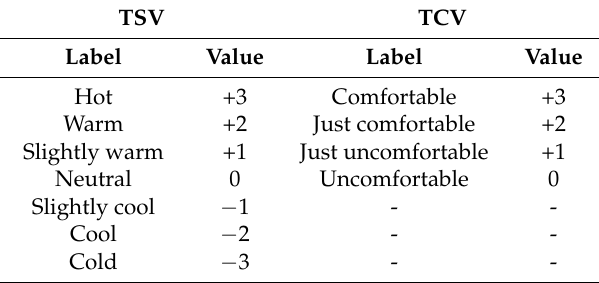
Table 2. Comfort scales used in the experiments. TSV and TCV denote thermal sensation and thermal comfort votes.